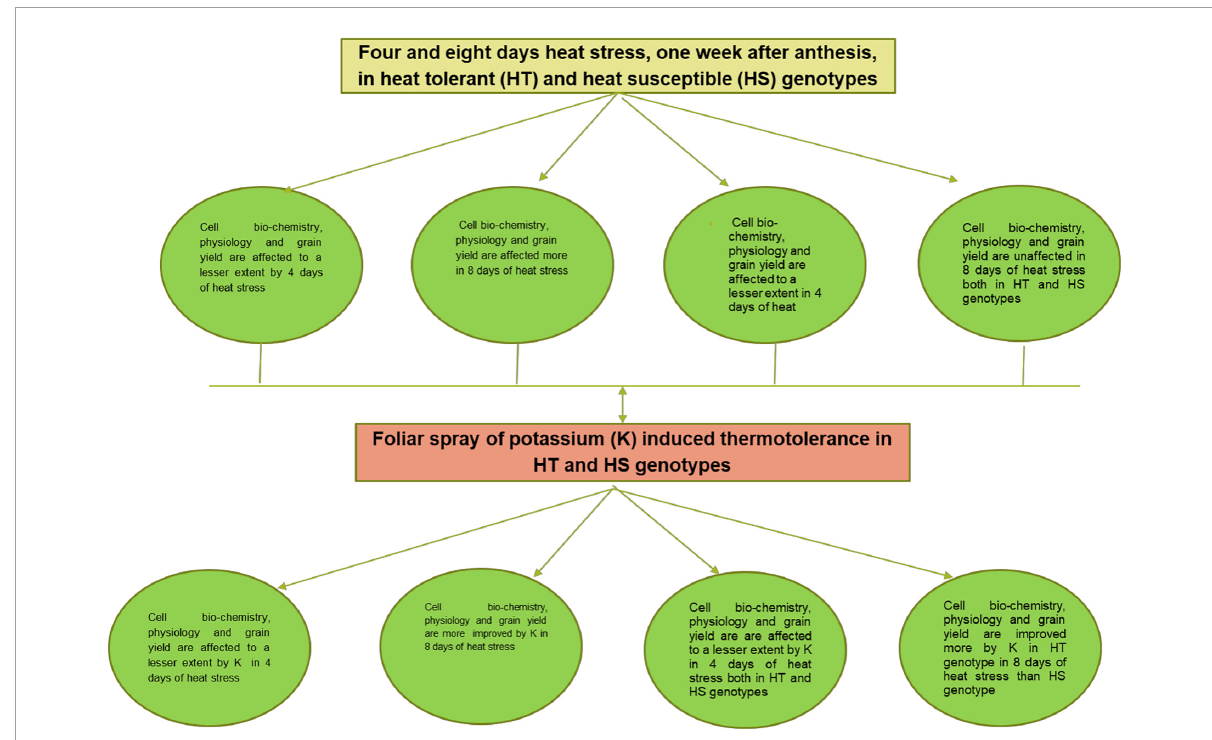
FIGURE5 Flow diagram for the effects of post-anthesis heat stress on wheat crop and the role of foliar spray of potassium for inducing thermotolerance in